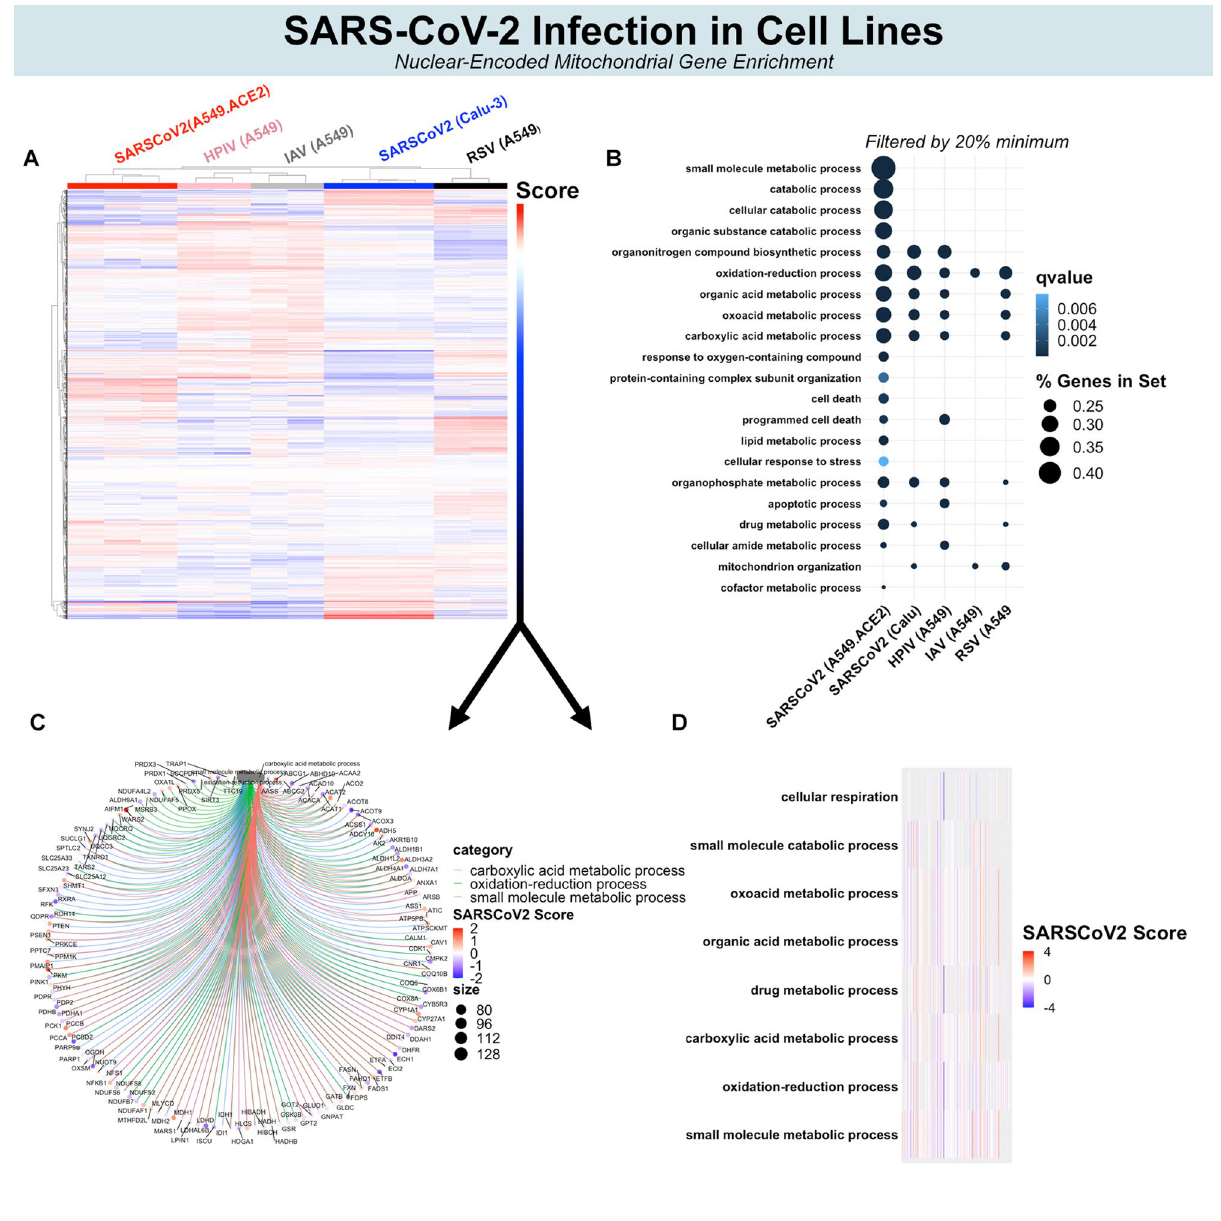
Figure 4. Biological processes affected by NEM expression in cell lines. Hierarchical clustering of all NEMs separate SARS-CoV-2 from other viruses ( A ). Top NEM biological processes by > 20% gene set enrichment ( B ). Top NEM biological processes by q value. ( C ) Circos plot illustrating significant NEMs and interconnectedness among biological processes. ( D ) Heat map representing the top 10 GO